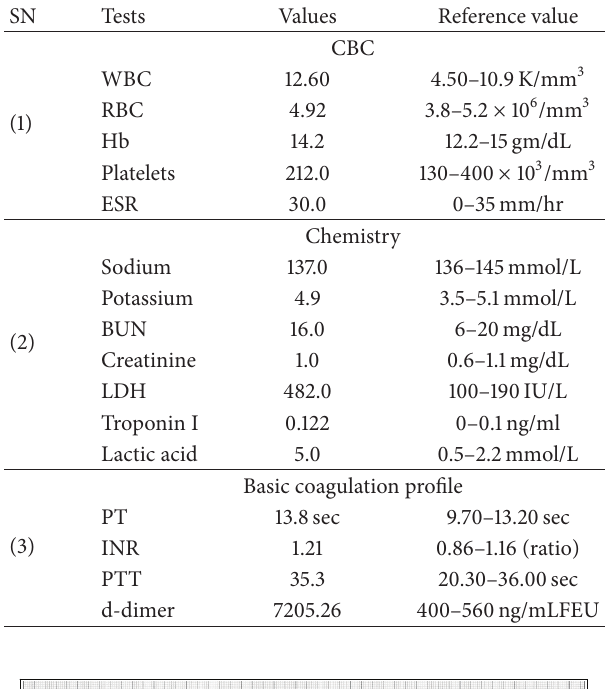
Table 1: Baseline laboratory findings in the patient at presentation.